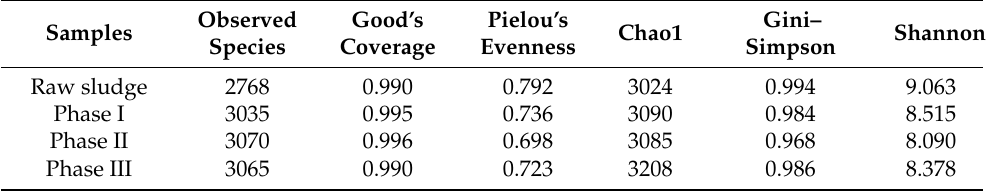
Table 3. Alpha diversity indices in activated sludge samples during the experiment.